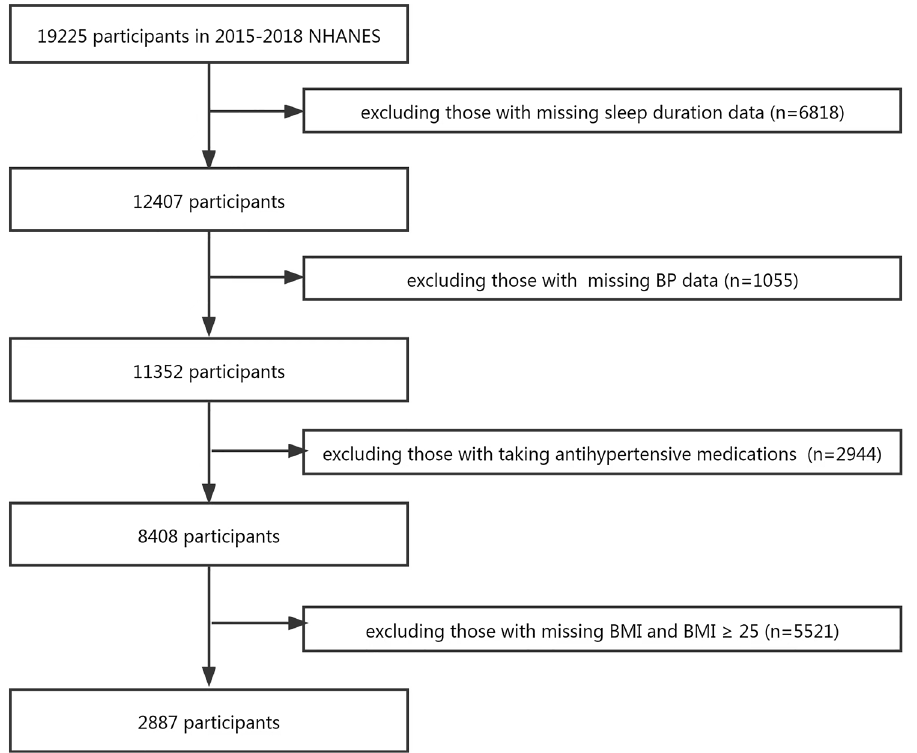
Figure 1. Flow chart and study design. BP blood pressure, BMI body mass